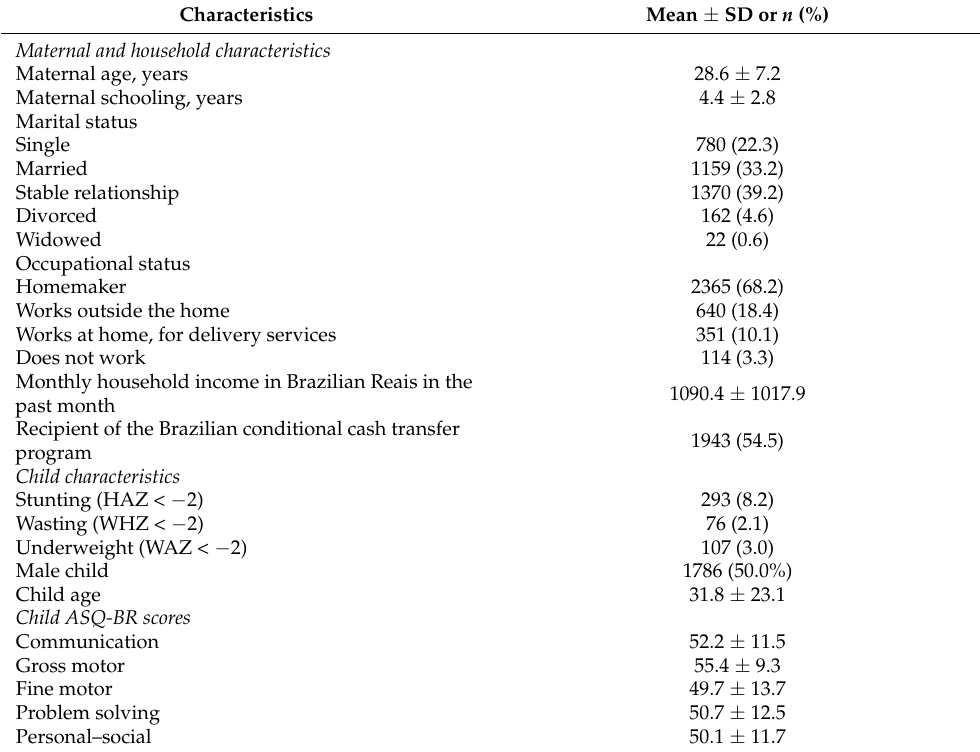
Table 1. Characteristics of 3566 children aged 0–72 months of age that participated in the PESMIC survey in Cear á ,